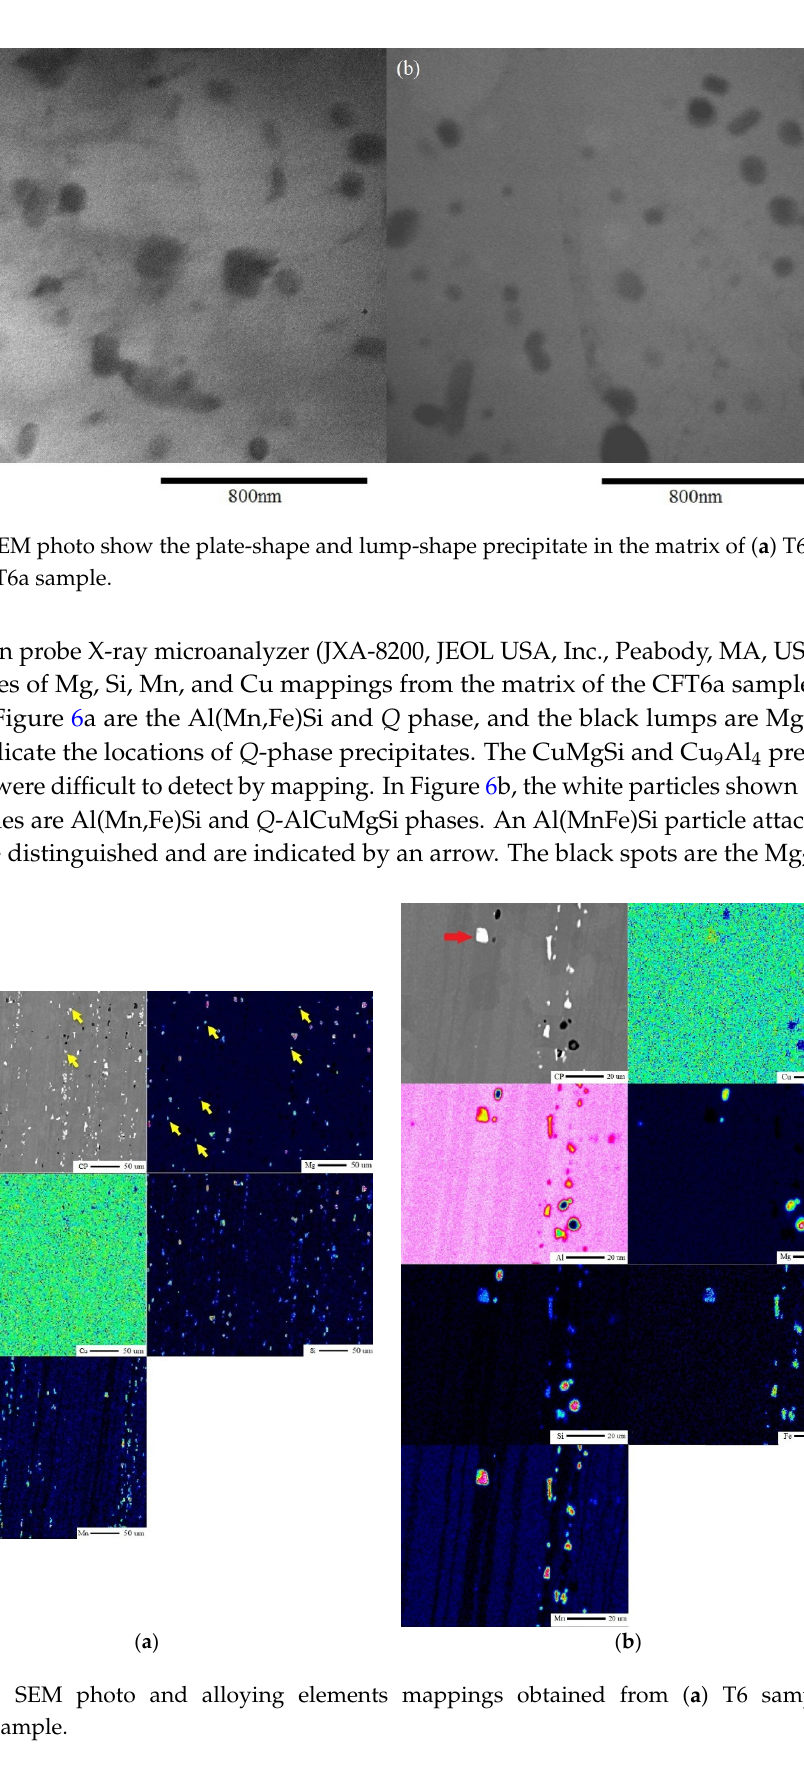
Figure 6. SEM photo and alloying elements mappings obtained from ( a ) T6 sample and ( b ) CFT6a sample. An electron probe X ‐ ray microanalyzer (JXA ‐ 8200, JEOL USA, Inc., Peabody, MA, USA) was used to obtain images of Mg, Si, Mn, and Cu mappings from the matrix of the CFT6a sample. The white aggregates in Figure 6a are the Al(Mn,Fe)Si and Q phase, and the black lumps are Mg 2 Si particles. The arrows indicate the locations of Q ‐ phase precipitates. The CuMgSi and Cu 9 Al 4